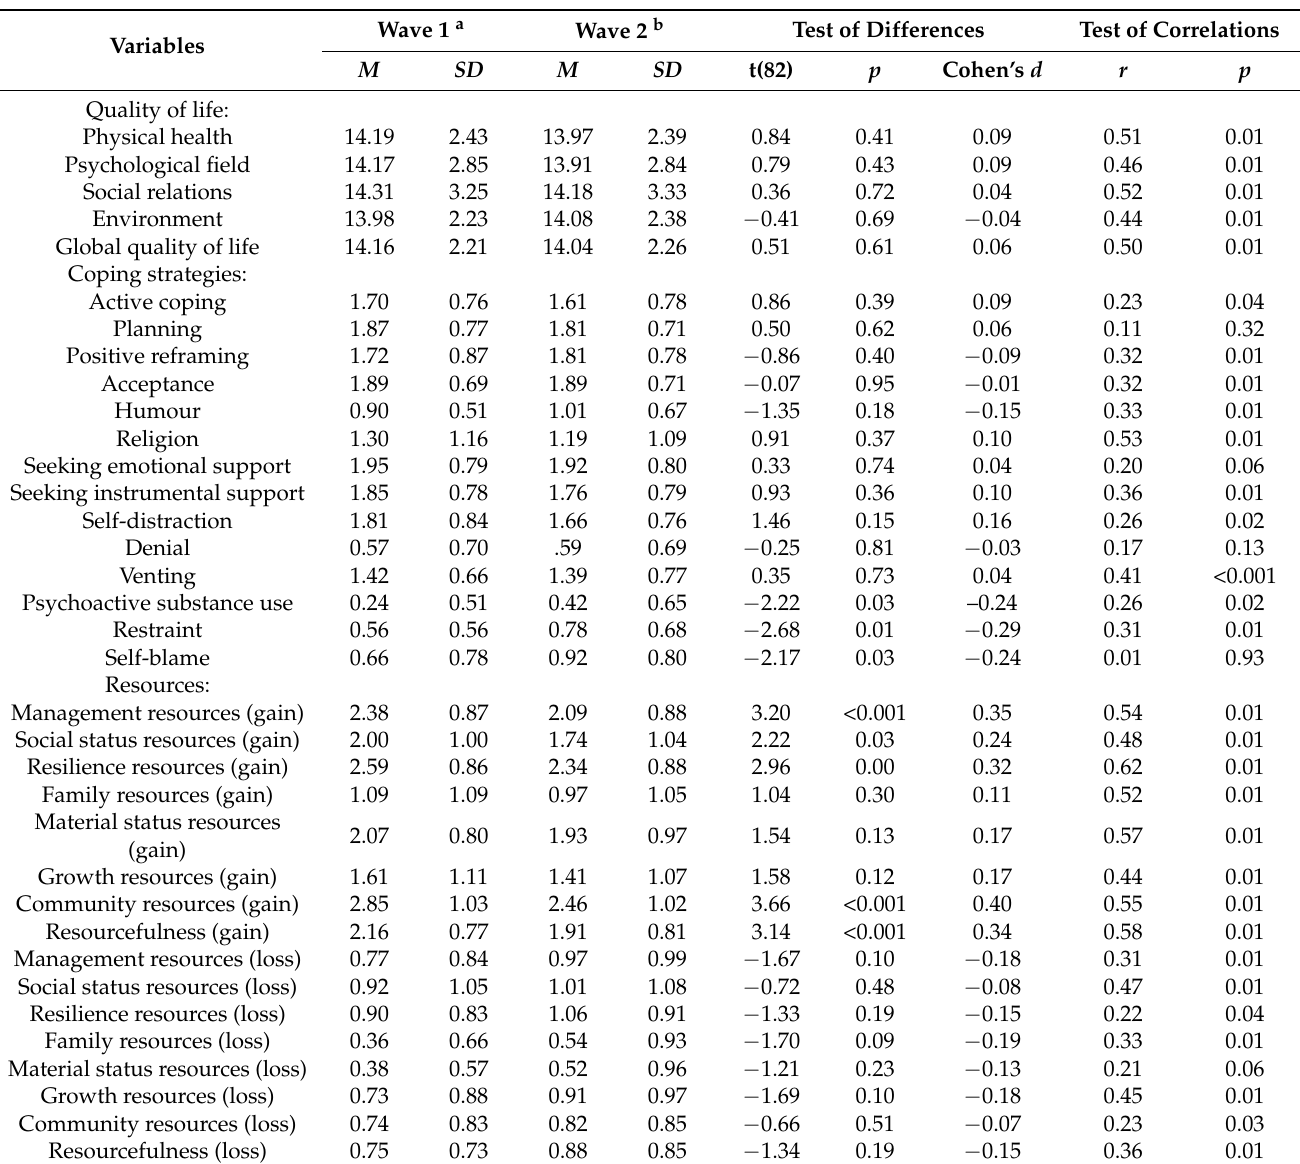
Table 1. Results for Quality of Life, Stress Coping Strategies, and Resource Gain and Loss in Two Pandemic Periods: Longitudinal Study